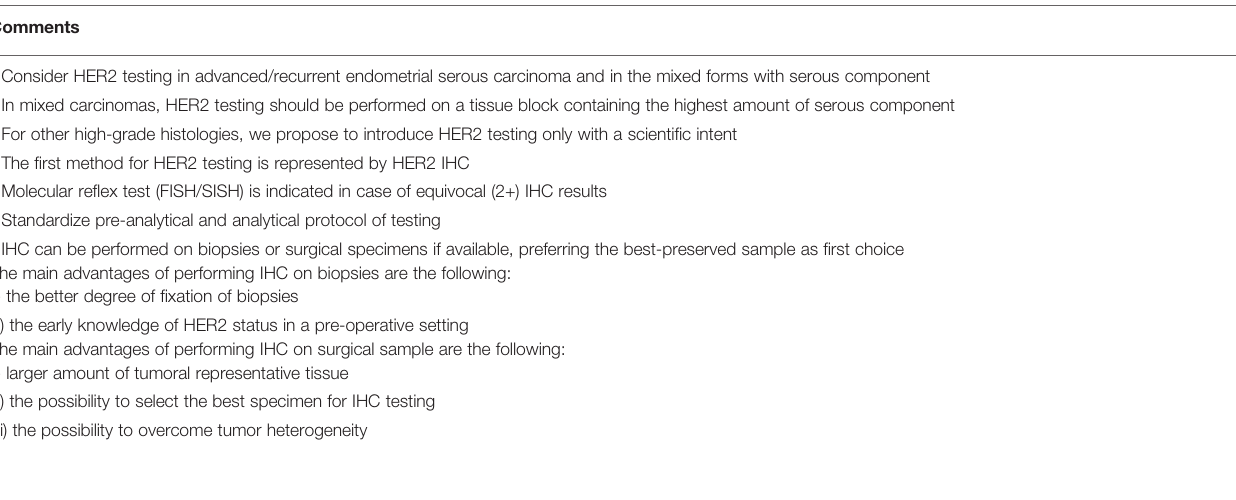
TABLE 8 | HER2: comments from the working